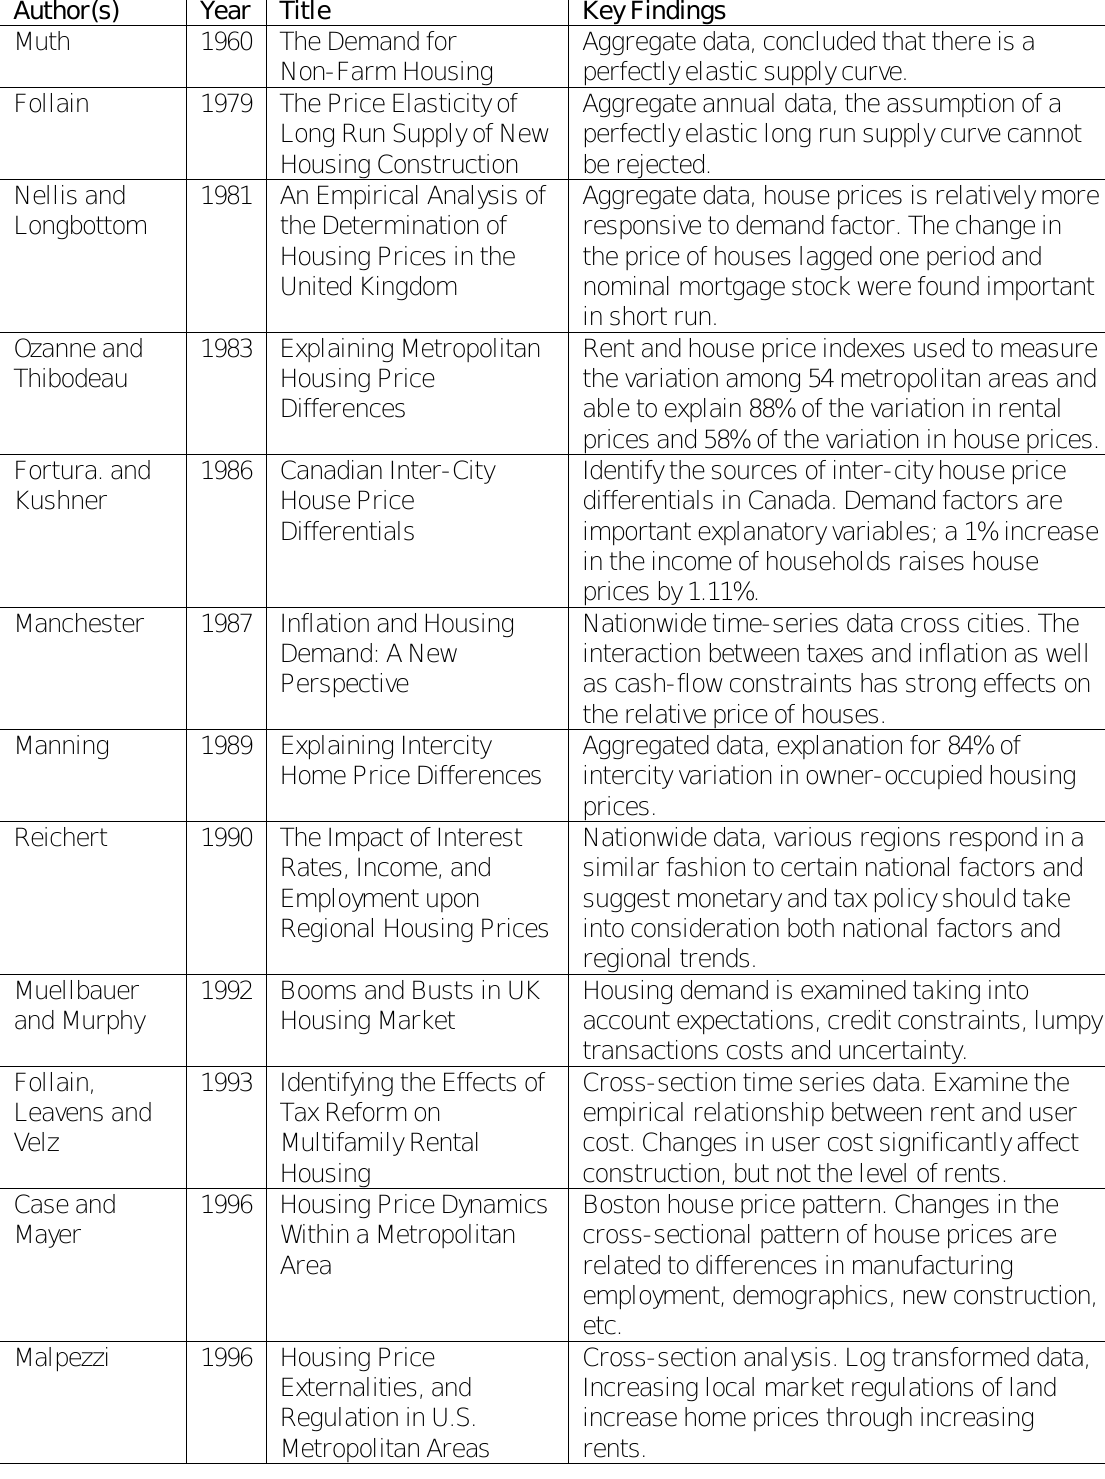
Table 2: Application of reduced form house prices